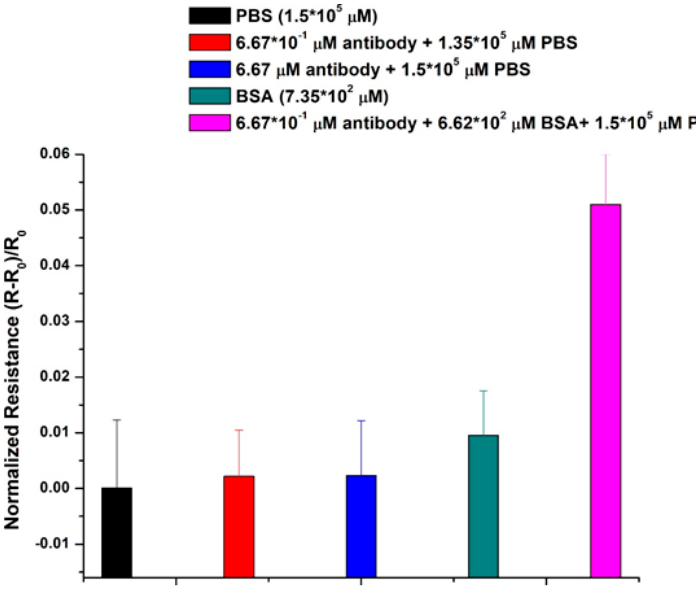
Figure 4. The variation of semiconductor sensor’s surface resistance (response function) using different samples.